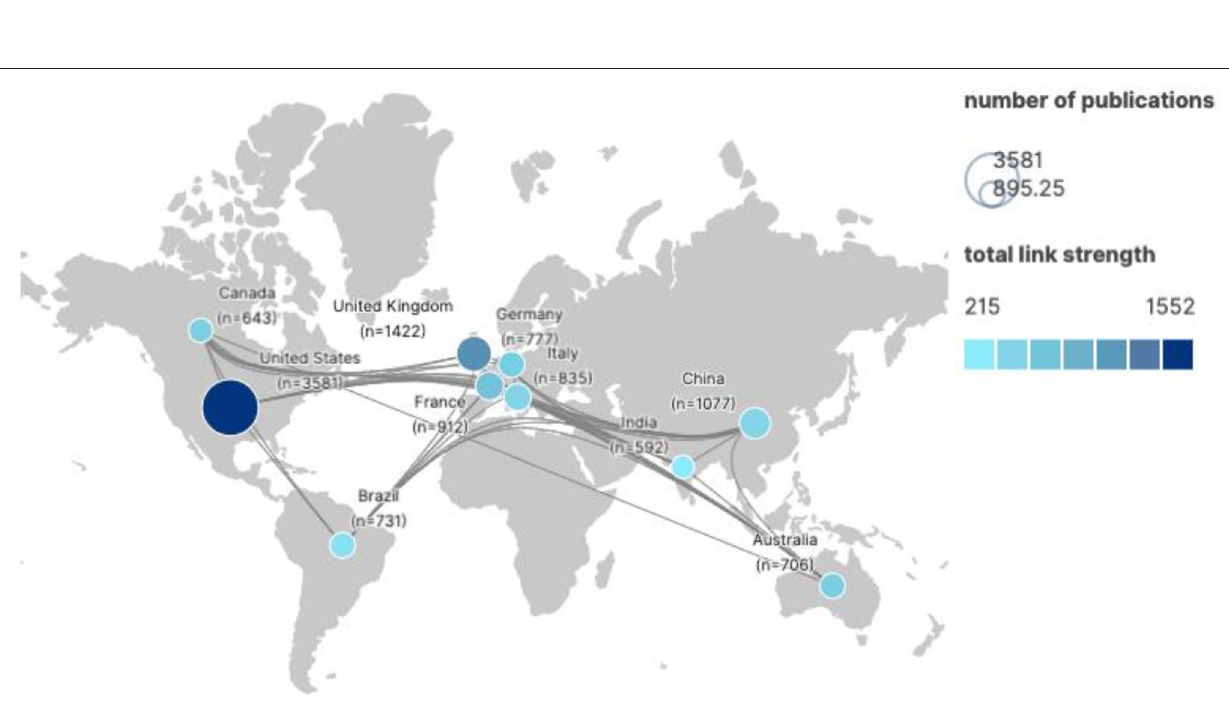
Frontiers in Public Health |